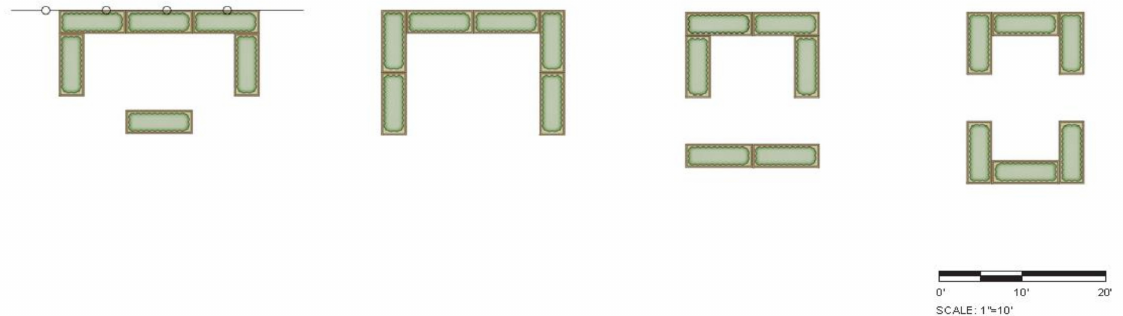
Figure 2. Four possible raised bed garden configurations allow for working from most sides and in-ground planting of annual vegetables and perennial fruiting